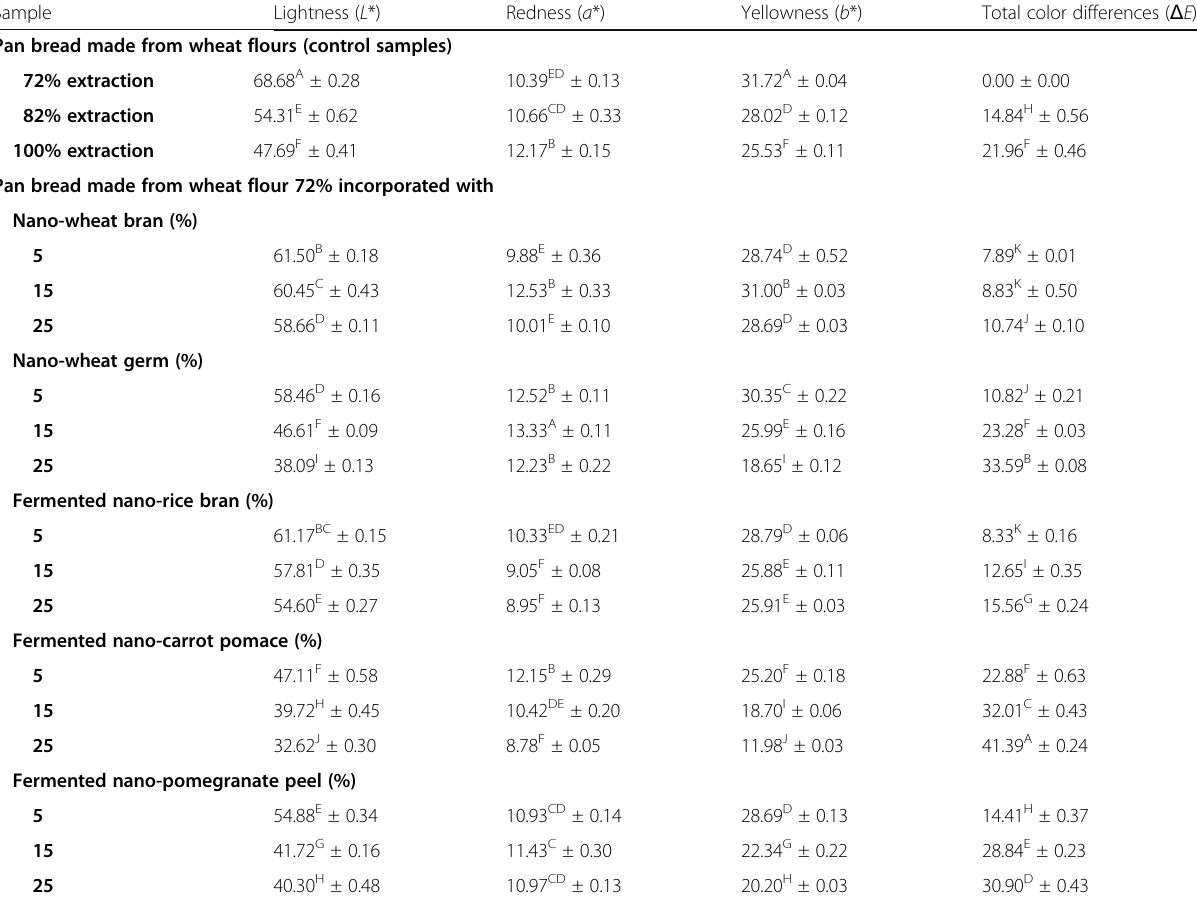
Table 4 Color attributes of pan bread crust as affected by addition of nano and fermented nano materials